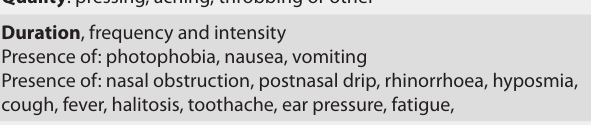
test positivity Details of past of nasal